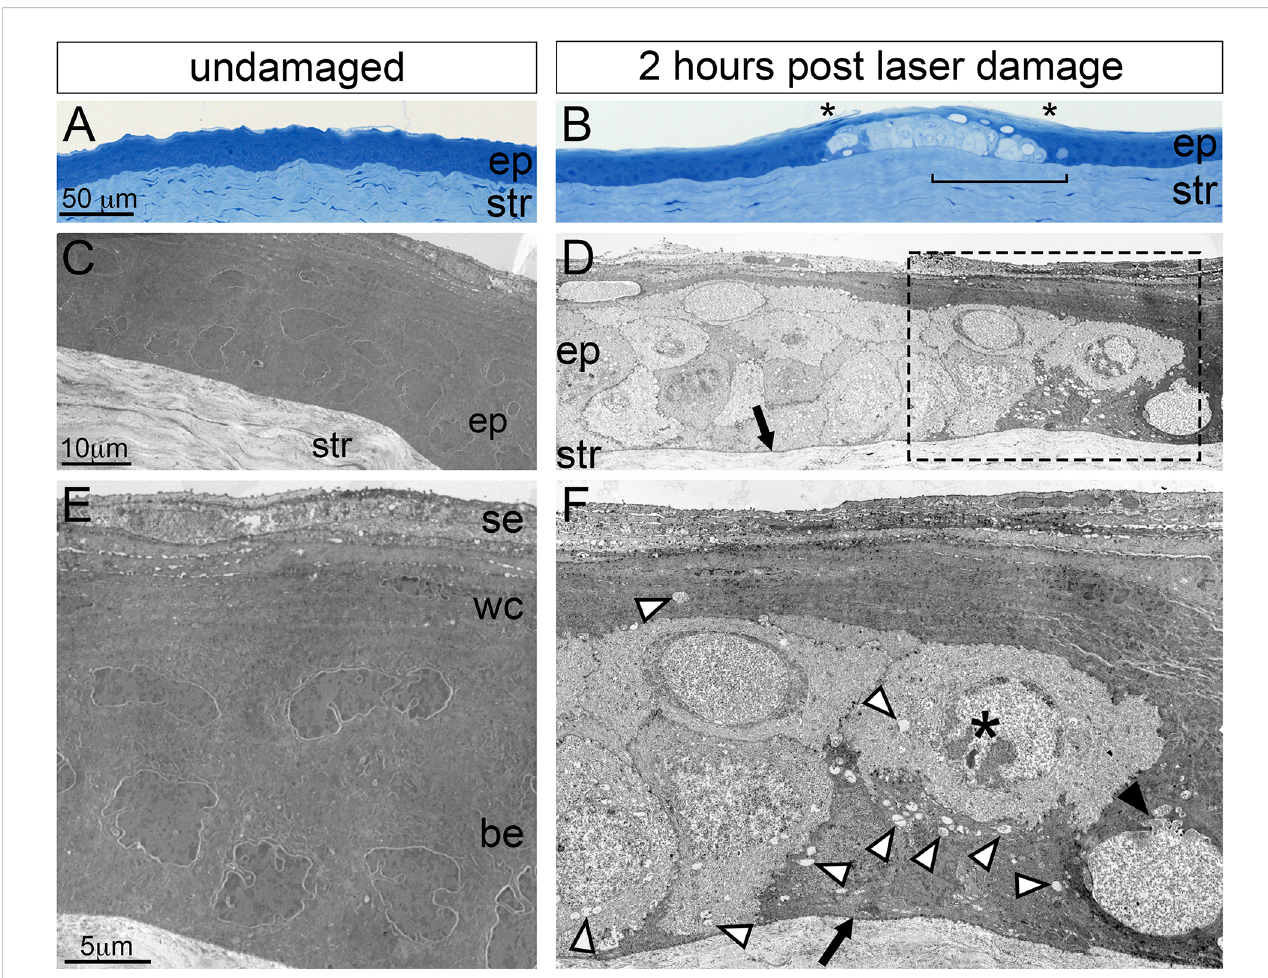
FIGURE 4 Histological analysis of corneal microdamage by light and transmission electron microscopy. Light microscopy imaging of toluidine blue stained Epon sections showing the corneal epithelial (ep) and stromal (str) layers in (A) undamaged and (B) microdamaged corneas. Damaged basal epithelium in (B) is bounded by asterisks characterized of the cytoplasm. The bracketed region in (B) corresponds to a similar region in panel (D) . (C, D) Transmission electron micrographs showing the corneal epithelium (ep) and stroma of (C) undamaged and (D) microdamaged corneas. Higher magni fi cation showing the corneal epithelium (E, F) . The arrows in (D, F) indicates an intact basement membrane. The white arrowheads in (F) point to vacuoles, the black arrowhead in (F) points to a disrupted nuclear membrane, the “ * ” indicates a nucleus with bleached, disrupted morphology. se, super fi cial epithelium; wc, wing cell regions; be, basal